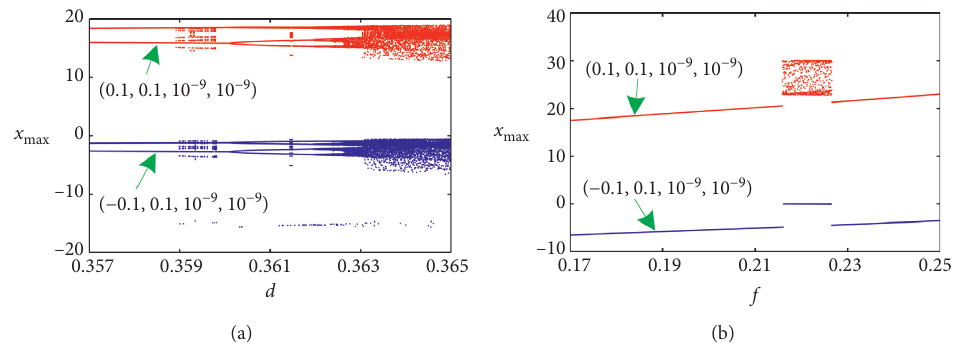
Figure 6: Numerically simulated 1D bifurcation plots of the maxima of the variable x in two narrow parameter ranges of d and f , re- spectively. (a) The parameter d varying with f � 1.88. (b) The parameter f varying with d �